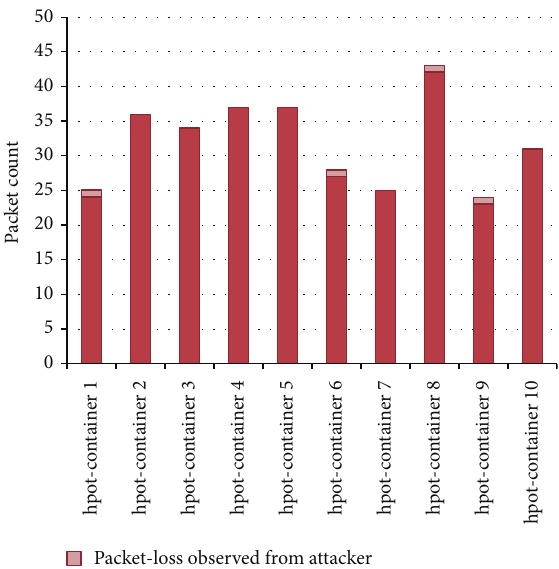
Figure 11: Chart giving out Hold-packet counts and packet-loss observed by an attacker during one of the 10-honeypot deployment trials involving sending an ICMP echo request every 50 ms, that is, rate of 20 packets/second.